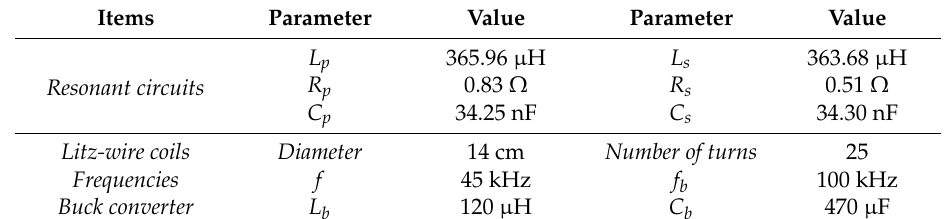
Table 1. Parameters of the system.